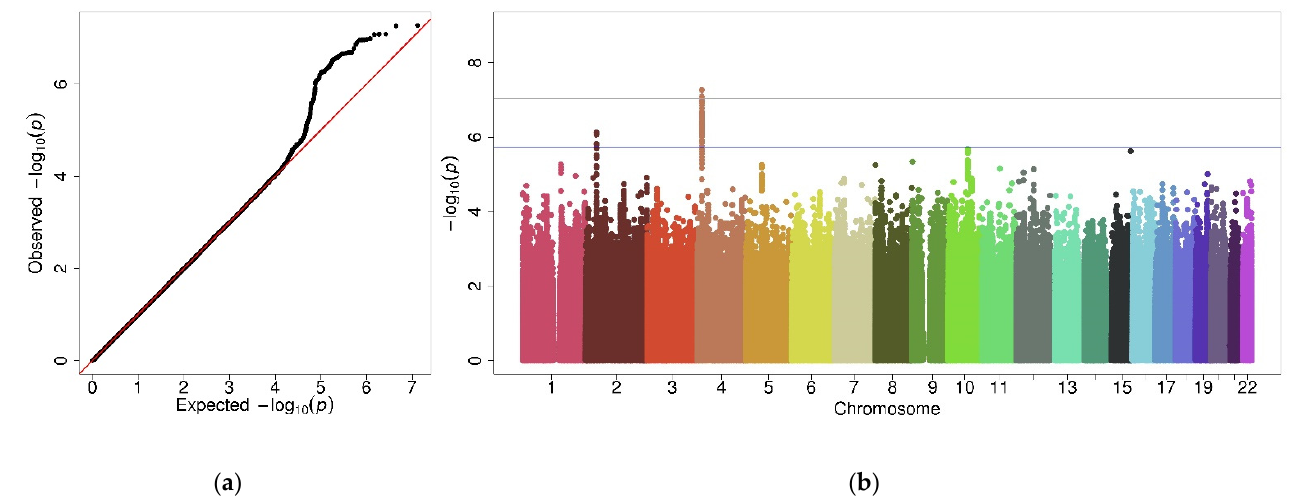
Figure 3. Graphic representation of results from male GWAS. ( a ) Q-Q plot of p -values and ( b ) Manhattan plot showing the association of genetic variants. The X -axis shows the chromosomal position for each variant and the Y -axis shows a transformation of significance ( − log 10 [ p -value]). The horizontal grey line shows the genome-wide significance threshold ( p -value = 9.4 × 10 − 8 ) whereas the suggestive significance threshold ( p -value = 1.9 × 10 − 6 ) is represented by the blue line.